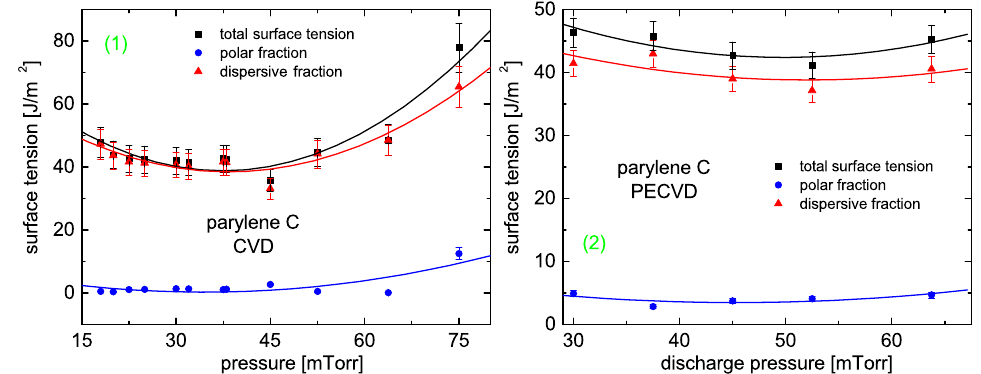
Figure 25. Different shape of the surface tension of CVD parylene C ( 1 ) and PECVD parylene C ( 2 ). Microwave power was between 75 and 100 W (0.9 W/L and 1.1 W/L, n p between 6 × 10 8 /cm 3 and 1 × 10 10 /cm 3